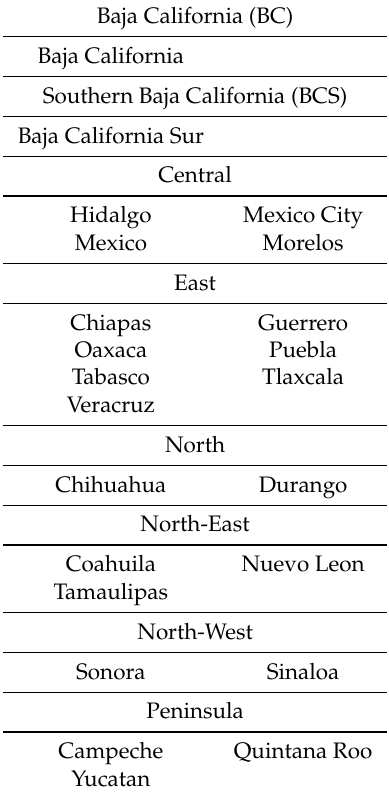
Table A1. States and their corresponding